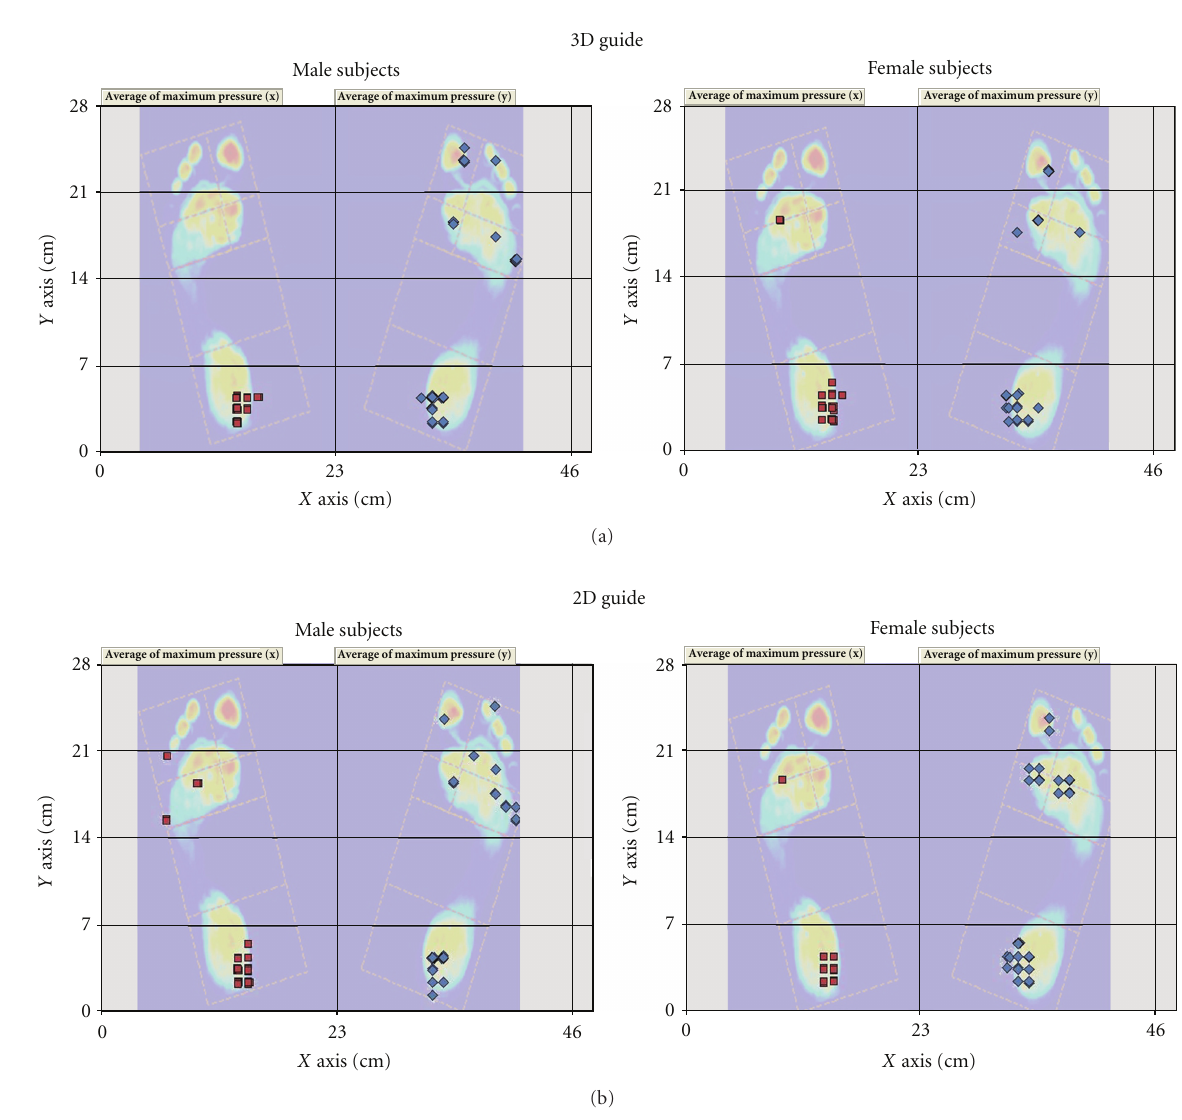
Figure 8: Pressure distribution patterns, including maximum